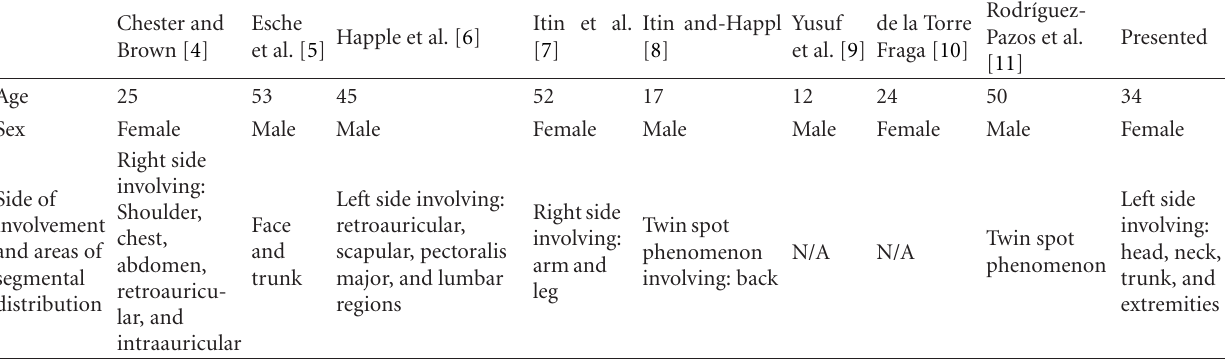
Table 1: Summary of the literature search of type 2 segmental cases.